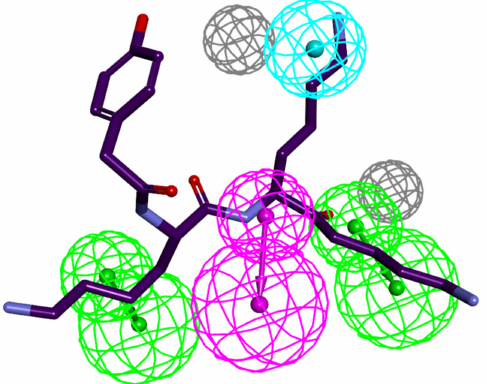
Figure 8. The best virtual hit, analogue PEP-14-14-14-18 (with purple carbons atoms), mapped a PH4 Hypo 1.